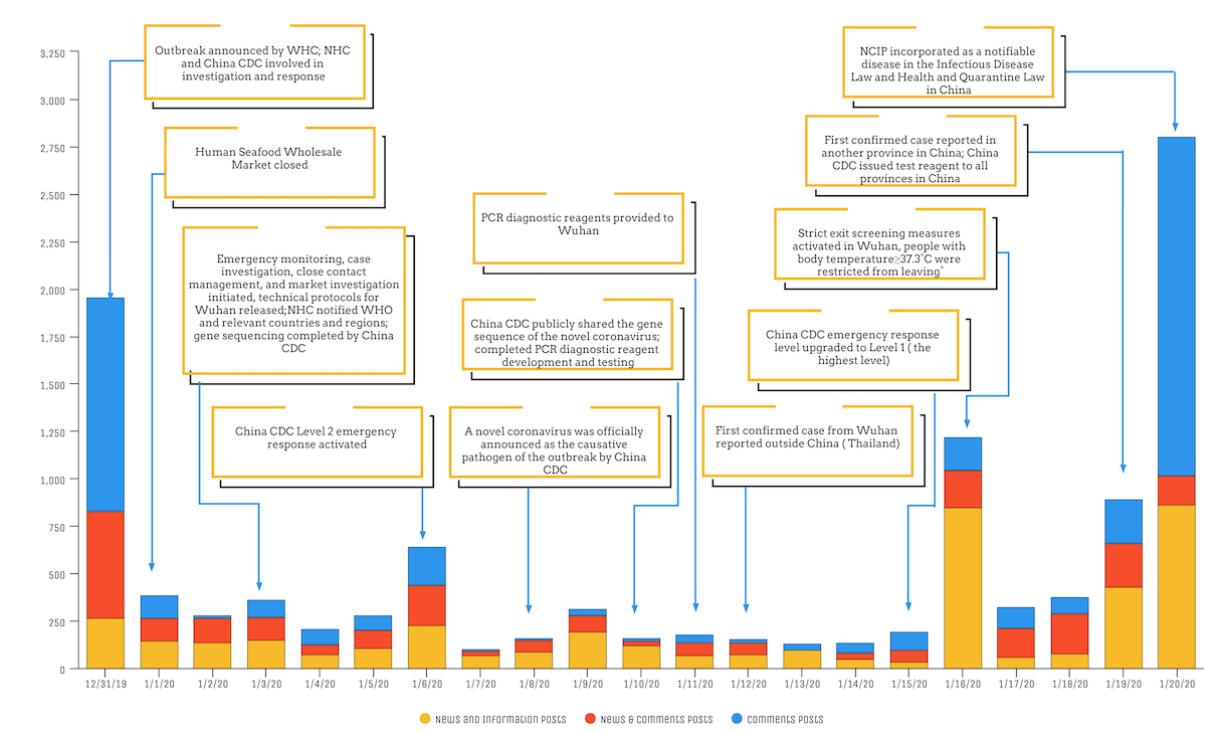
Figure 1. The number of Weibo posts related to the COVID-19 outbreak by information source category and with a timeline of events (December 31, 2019, to January 20, 2020). CDC: Center for Disease Control and Prevention; NCIP: novel coronavirus-infected pneumonia; NHC: National